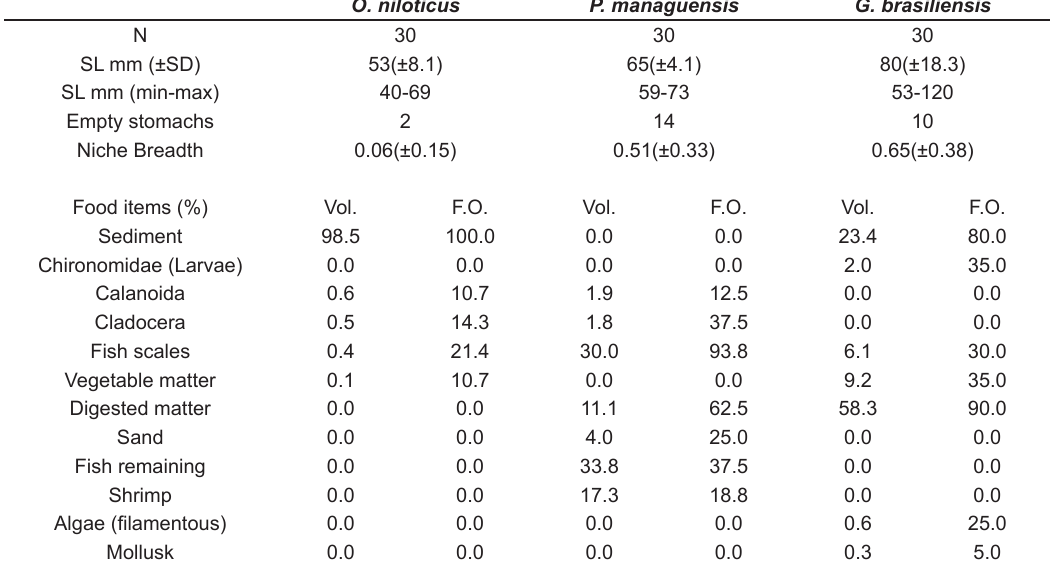
Table 1. Data on fish size, stomach fullness and food items consumed by O. niloticus , P. managuensis and G. brasiliensis .